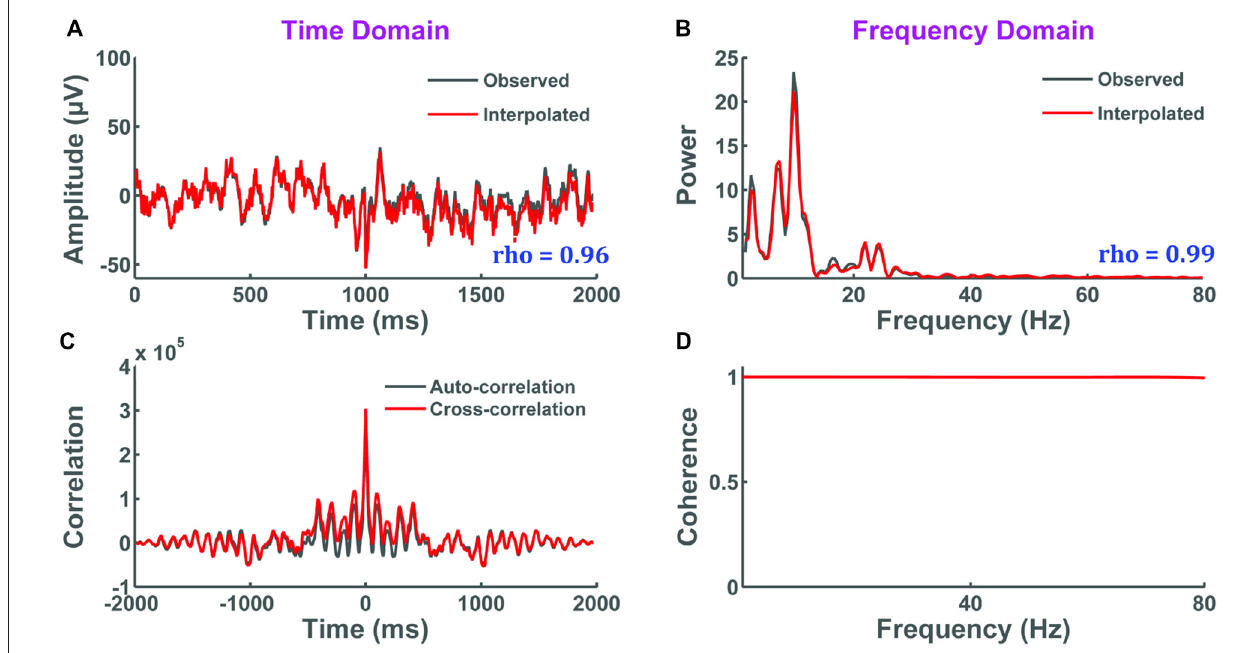
FIGURE 9 | The impact of selective interpolation on data integrity. In this figure, we compare data from channel FC3 before (original) and after (interpolated) selective interpolation of a trial within FC3. (A) Amplitude of the original signal overlapped with the amplitude of the interpolated signal showing high correlation between the two signals in the time domain. X -axis represents time in milliseconds and y -axis represents the amplitude of the EEG signal in µ V. (B) Power spectral density of the original signal overlapped with the power spectral density of the interpolated signal showing high correlation between the two signals in the frequency domain. X -axis represents frequency in Hertz and y -axis represents the spectral power of the EEG signal in µ V 2 /Hz. (C) The cross-correlation between the original and interpolated signal closely matches with the autocorrelation of the original signal. X -axis represents the various time lags in milliseconds and y -axis represents the correlation coefficients at every time lag. (D) The coherence plot shows perfect coherence indicating that there is a high degree of linear dependency between the interpolated signal and the original signal. X -axis represents frequency in Hertz and y -axis represents the magnitude-squared coherence estimates using Welch’s averaged periodogram method at each